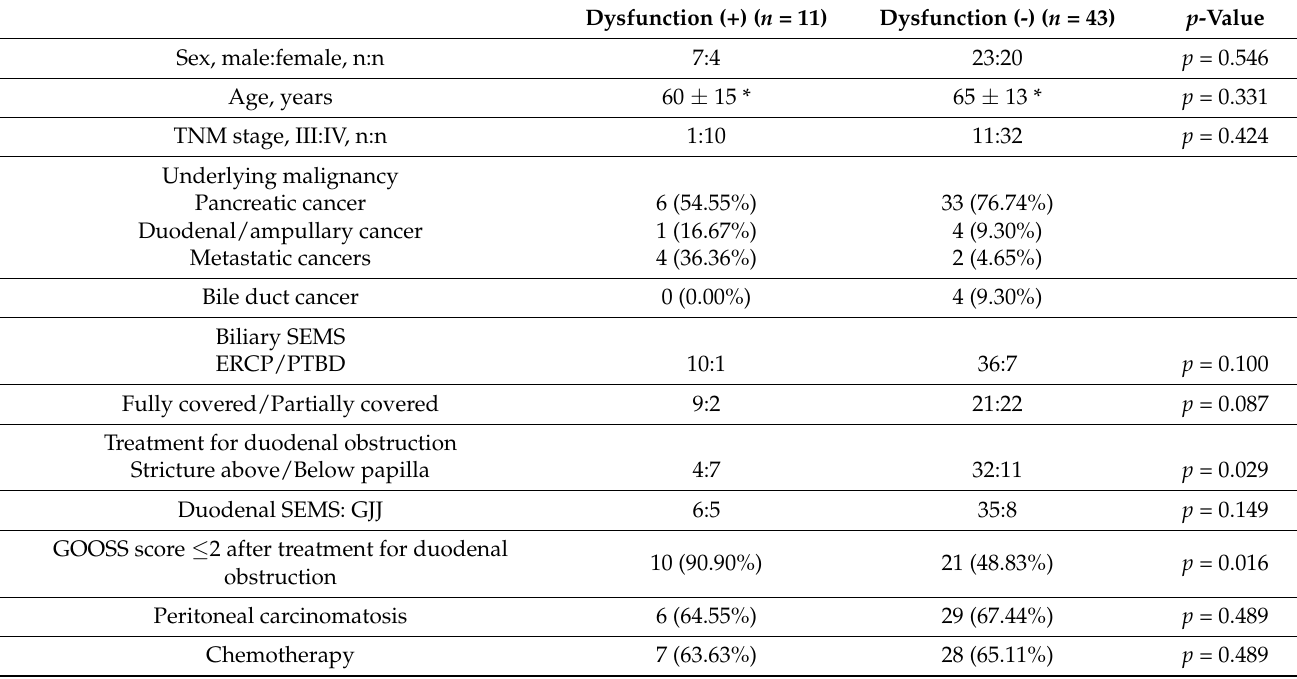
Table 2. Characteristics and outcome of patients with or without duodenobiliary reflux-related covered biliary self- expandable metal stent dysfunction after treatment of duodenal